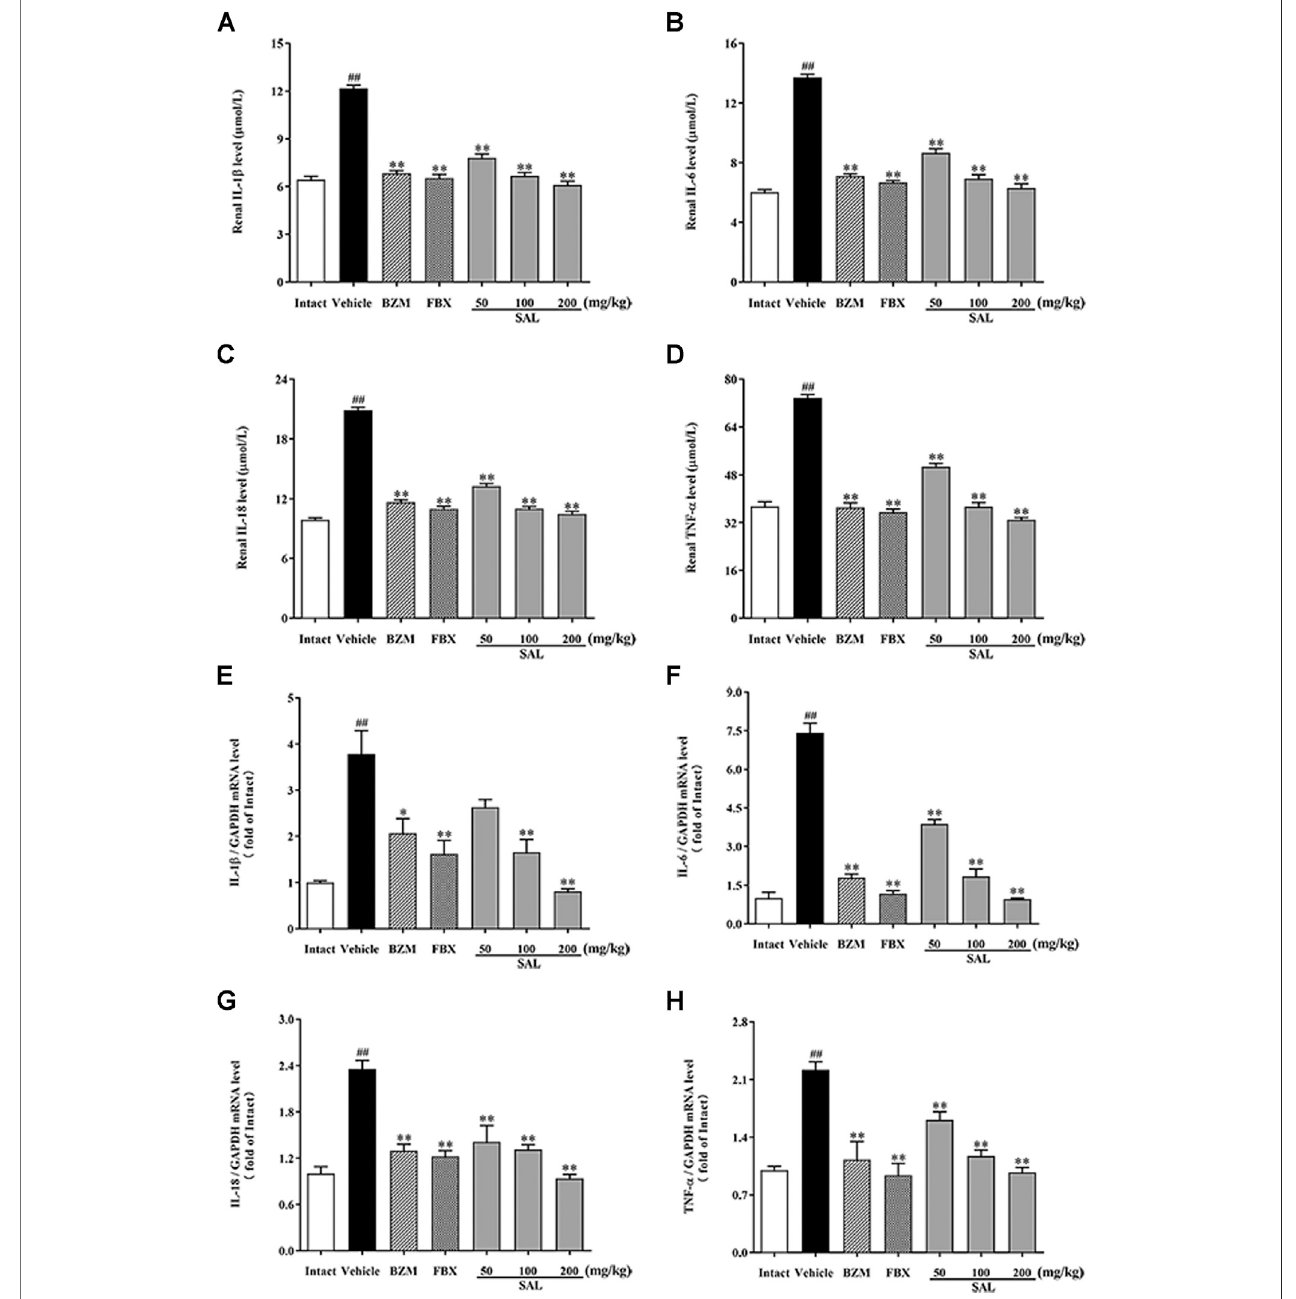
FIGURE7| EffectofSALonrenalin fl ammatorycytokines.Renal (A) IL-1 β ; (B) IL-6; (C) IL-18; (D) TNF- α ;mRNAexpressionof (E) IL-1 β ; (F) IL-6; (G) IL-18; (H) TNF- α . All data are expressed as mean ± SD ( n (cid:2) 8). ## p < 0.01 vs. the intact group, **p < 0.01 vs. the vehicle group.